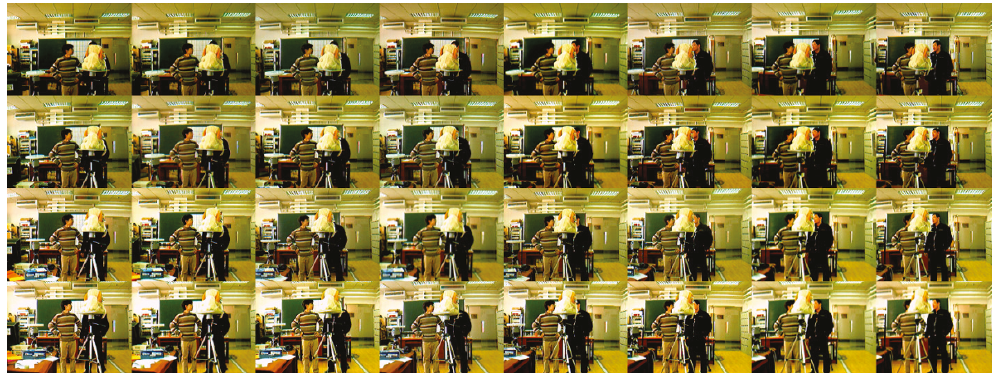
Figure 3: A snapshot of a DLF sequence ( room ) taken with our DLF rendering and streaming system.